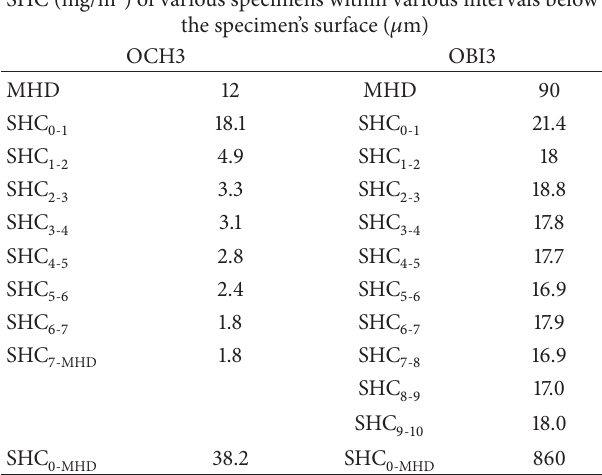
Table 5: Values of MHD ( 𝜇 m) and SHC for OCH3 and OBI3 proc- esses. SHC (mg/m 2 ) of various specimens within various intervals